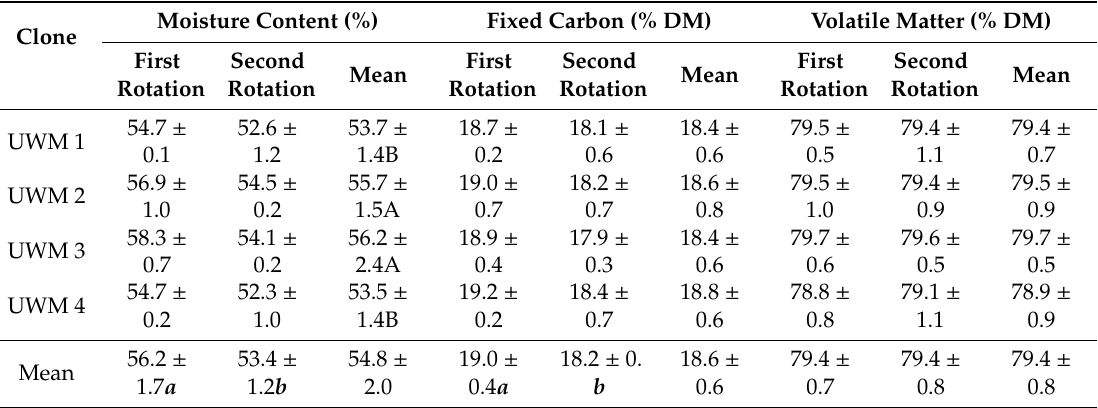
Table 3. Moisture content, fixed carbon and volatile matter content in the biomass of four poplar clones in two consecutive 4-year harvest